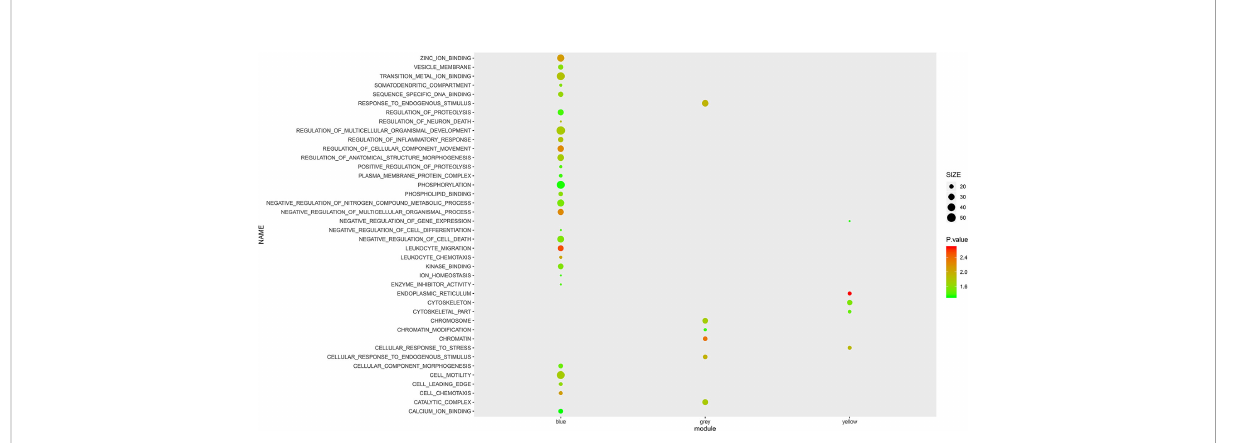
FIGURE 2 GSEA with GO terms on Blue, Yellow and Grey modules. The size and color intensity of a circle represent the numbers of mRNAs and − log 10 (P value) of enrichment for each